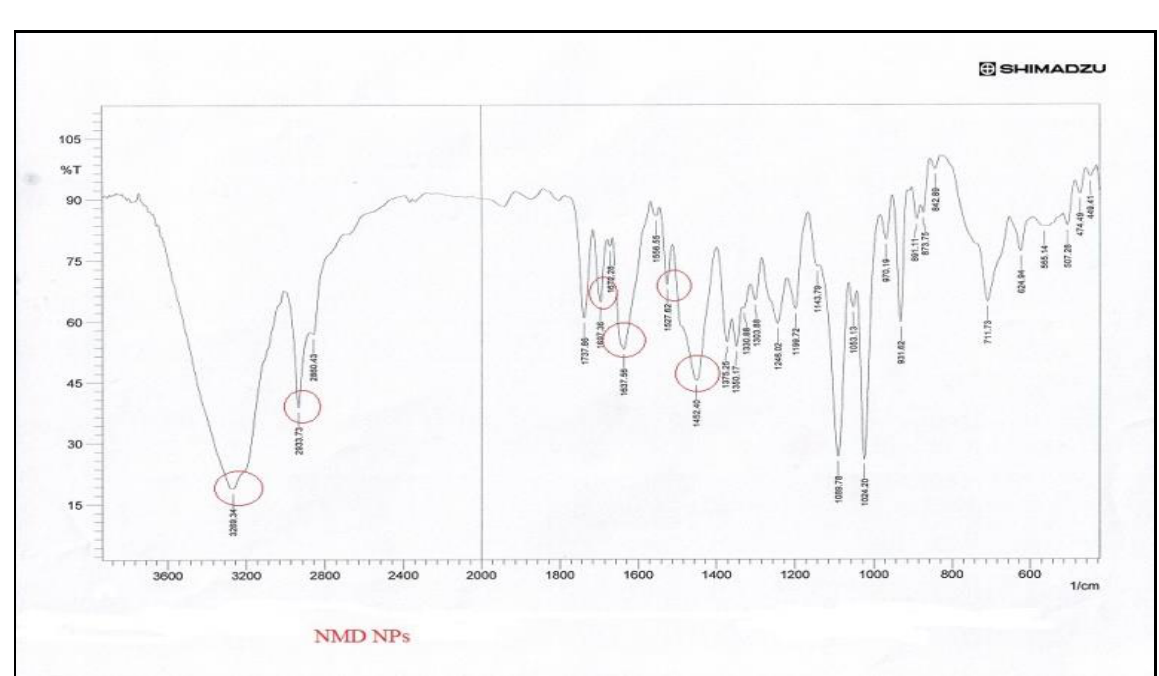
Figure 11. FTIR spectrum of NMD